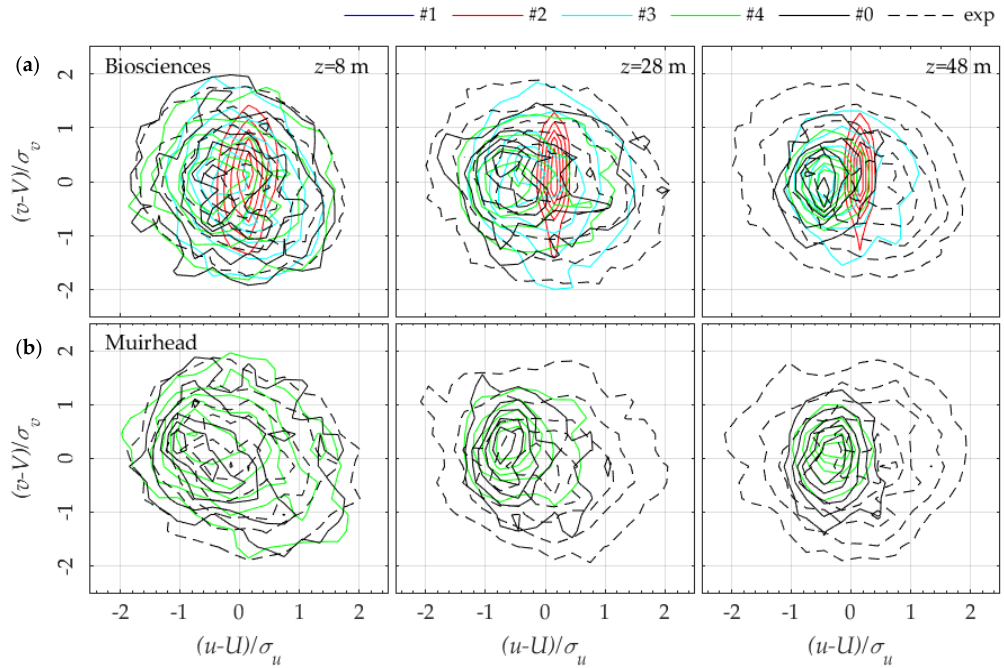
Figure 16. Joint Probability Density Function of the horizontal velocity at several heights above the Muirhead tower ( a ) and Biosciences tower ( b ).